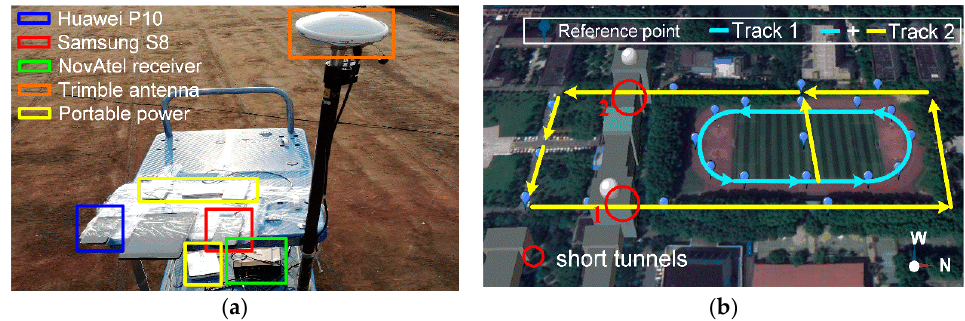
Figure 5. ( a ) The devices used in the static test. ( b ) The tracks and reference points in kinematic test.